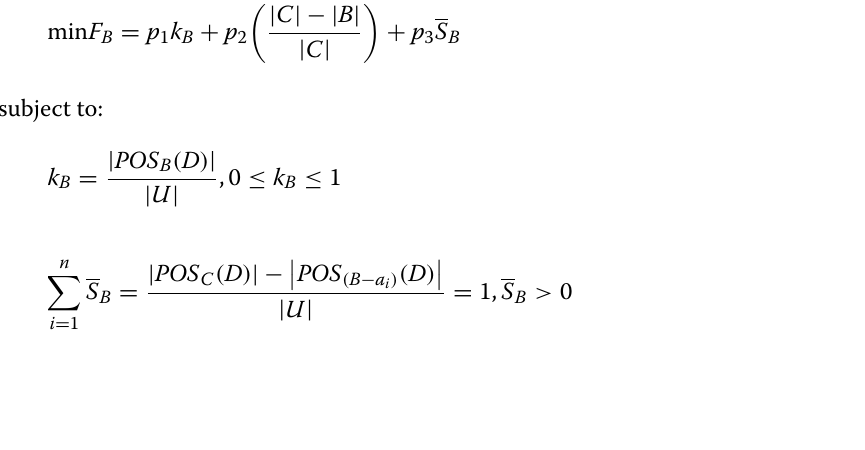
Table 2 Symbols used in the reduction model Sets and indices